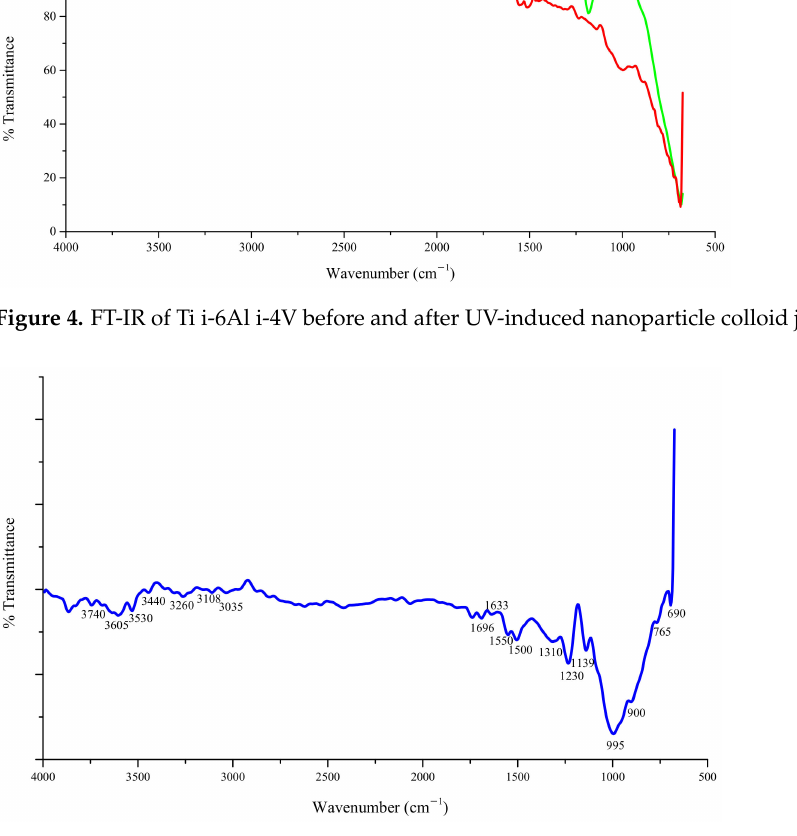
Figure 5. The FT-IR differential spectra of the Ti-6Al-4V workpieces.